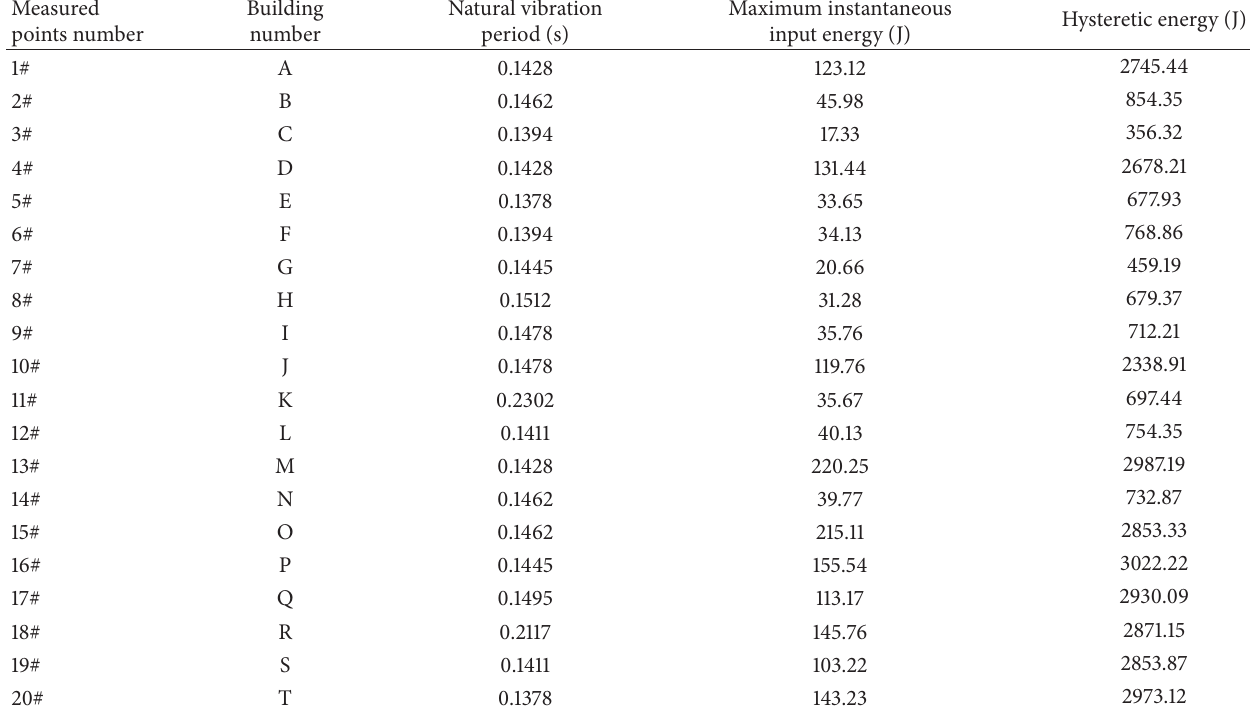
Table 4: Energy responses of the residential